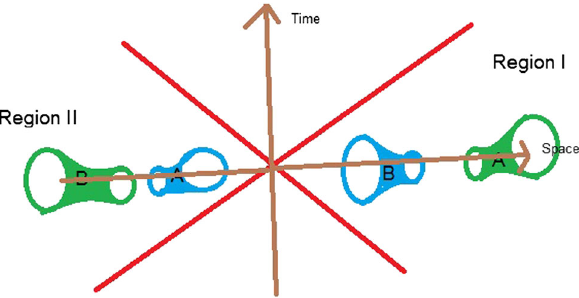
Fig. 1 Two parts of BIons in two regions of the Rindle space-time. Parts with green color are expanding and parts with blue color are con-